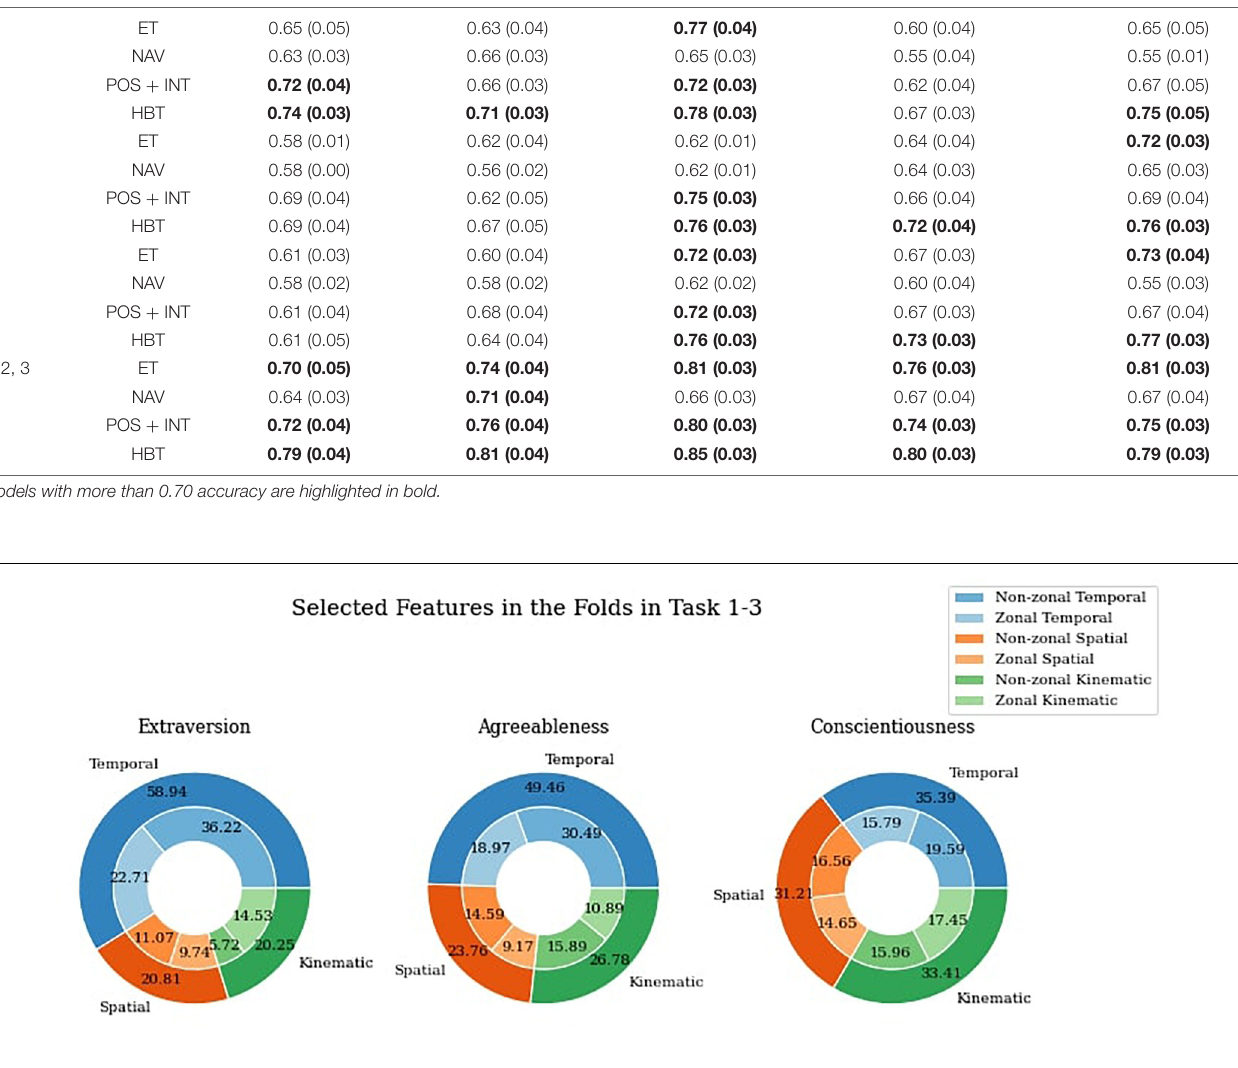
TABLE 2 | Accuracy of classification of personality domains over all iterations in tasks and signals. Task(s)